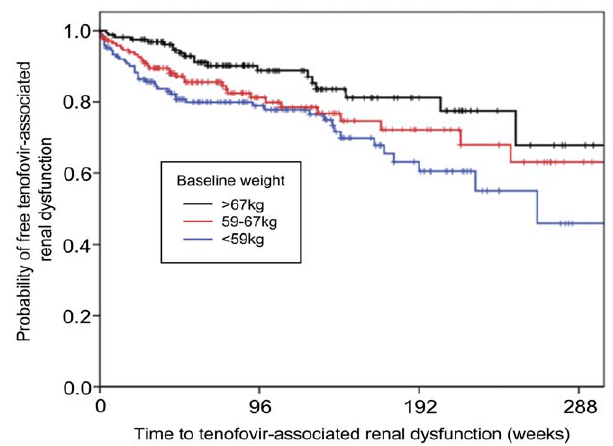
Figure 3. Kaplan-Meier curve showing the time to 25% reduction in eGFR according to baseline weight categories. Compared to patients with body weight . 67 kg, those with weight , 59 kg were more likely to develop . 25% decline in eGFR (P=0.002), whereas those with weight 59–67 kg showed only a marginal significance (P=0.073, log-rank test). eGFR: estimated glomerular